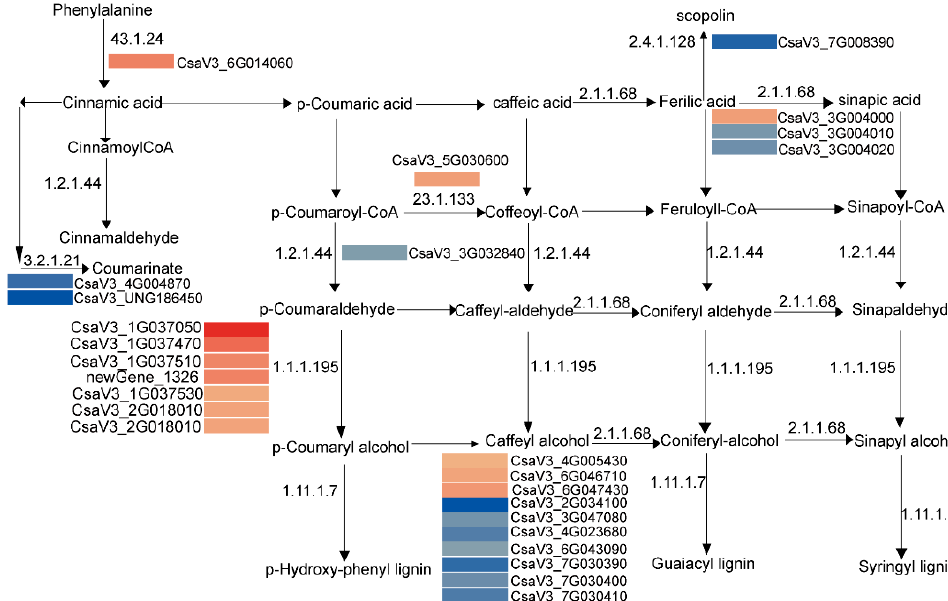
Figure 9. Process of phenylpropanoid biosynthesis was significantly different between CT57S and CT90R in roots. The process map was modified based on the map ko00940.